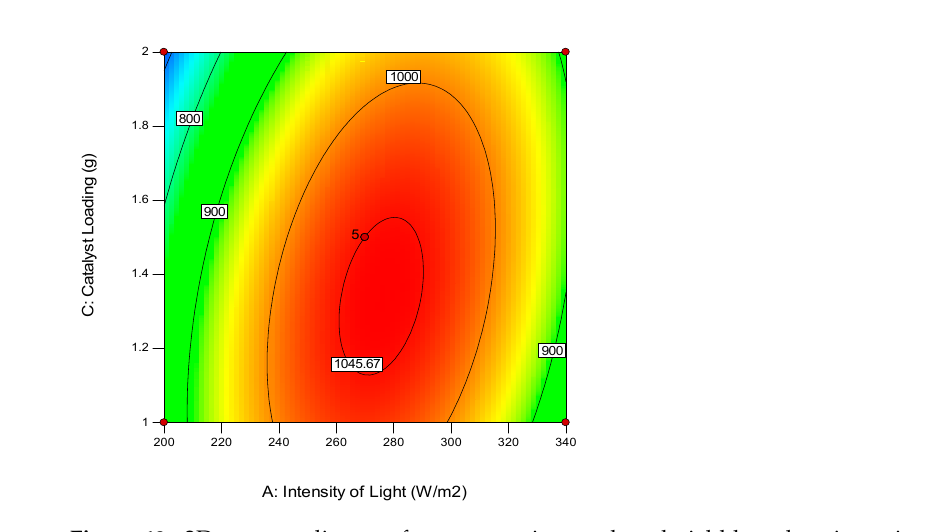
Figure 13. 2D contour diagram for representing methanol yield based on intensity of light and catalyst loading.